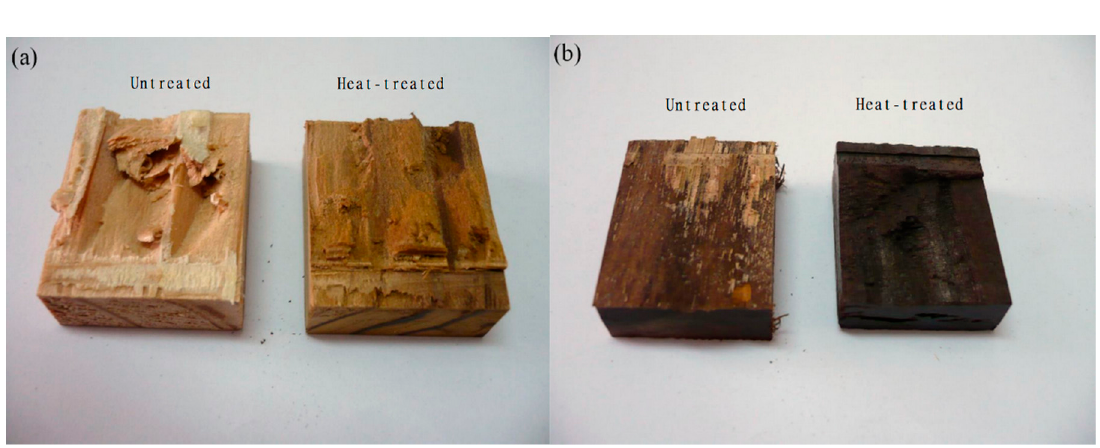
Figure 3. Appearance of untreated and heat-treated Japanese cedar ( Cryptomeria japonica D. Don) ( a ) and Formosa acacia ( Acacia confuse Merr.(Leguminosae)) ( b ) wood with urea-formaldehyde resin (UF) adhesive after the shear strength test.